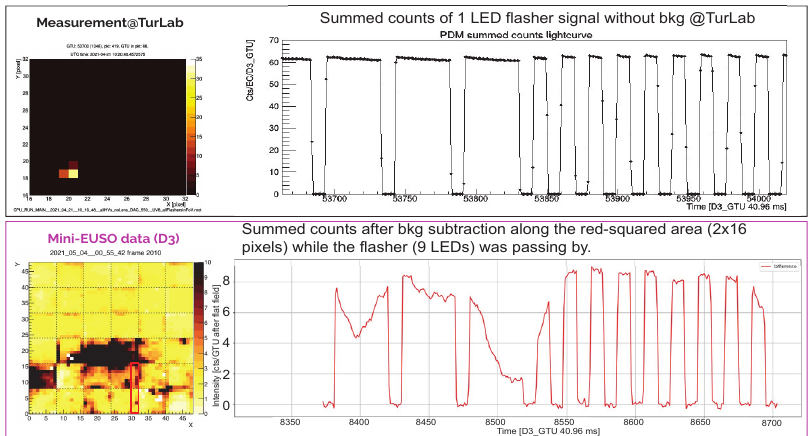
Figure 4: Image of a frame (left) and the lightcurve (right) of the flasher LED photons detected by the Torino EC at 40 m distance (top) and by Mini-EUSO on the ISS (bottom).